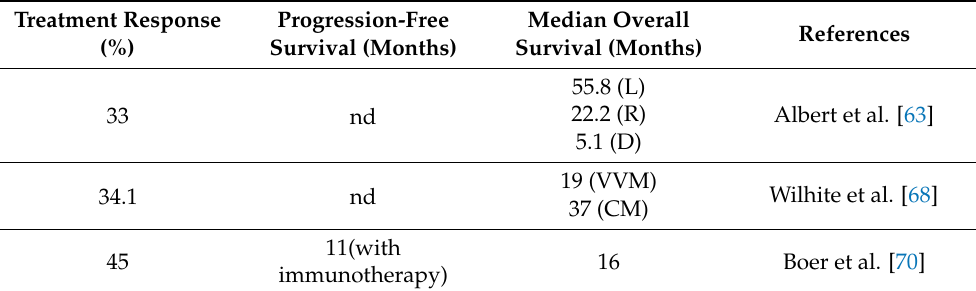
Table 4. Effects of immunotherapy in patients with vulvar and vaginal melanoma.